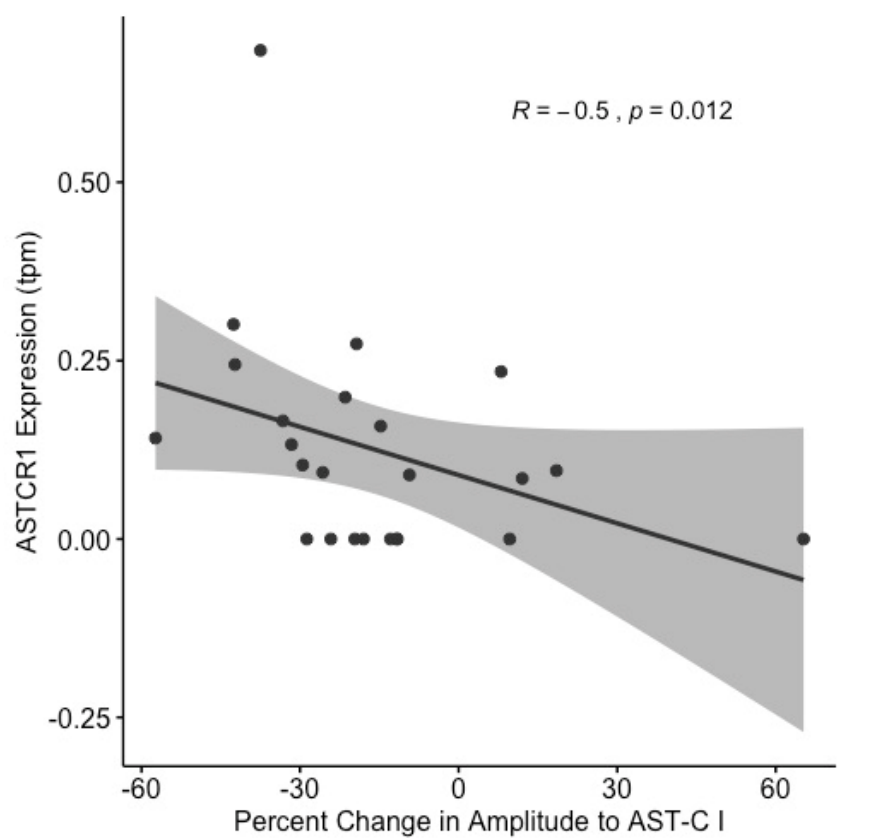
Figure 8. Differential expression of ASTCR1 is partly responsible for the great individual variability in physiological responses to AST-C. The percent change in amplitude to AST-C I and the CG expression (transcripts per million) of ASTCR1 are significantly negatively correlated (Spearman correlation, R = − 0.5; p = 0.012; n = 23 lobsters).